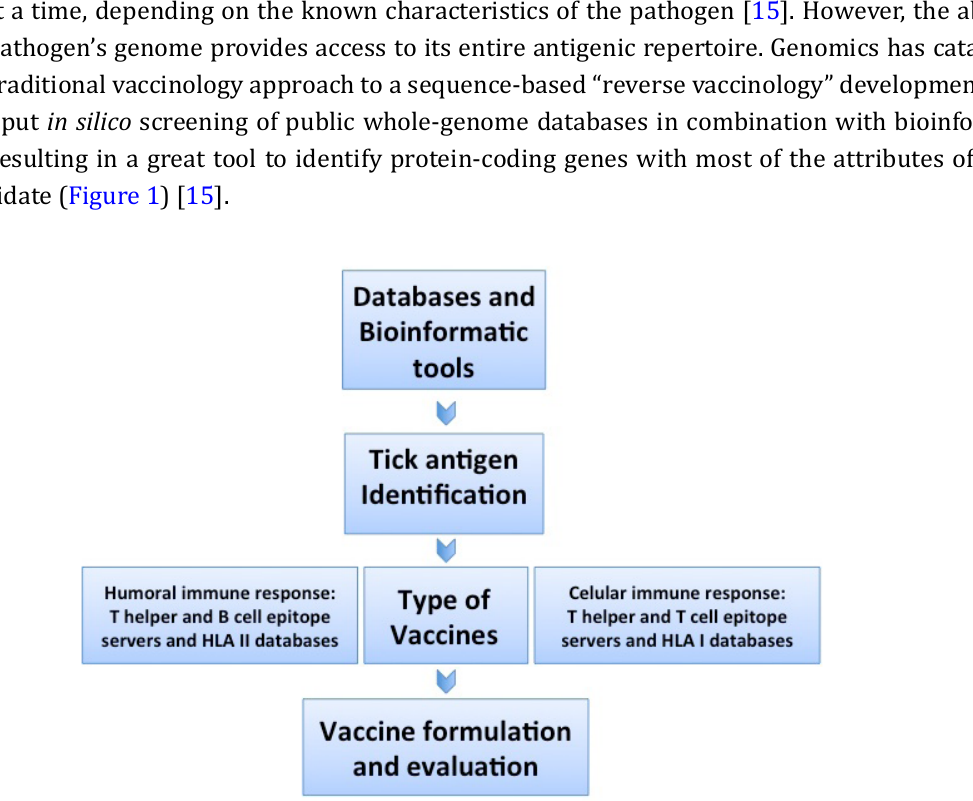
Figure 1. Reverse vaccinology pipeline starts using public databases to retrieve gene sequences of interest that can be processed in silico , in order to identify genes that encode proteins containing immunogenic linear B or T cell epitopes with the attributes of a good tick vaccine target. HLA: human leukocyte